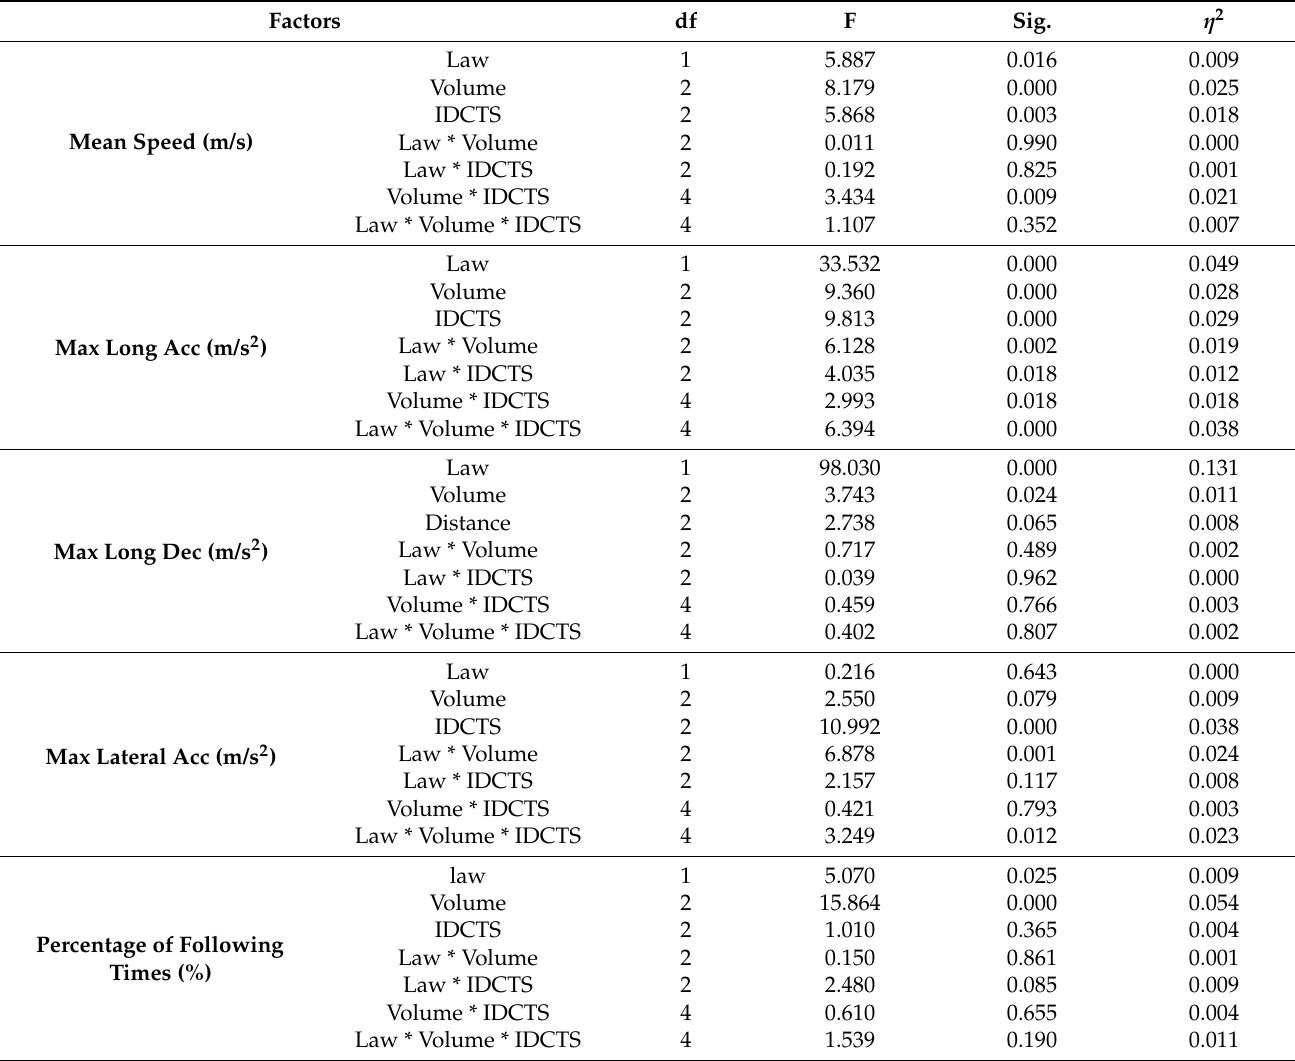
Table 4. Results of MANOVA for dependent